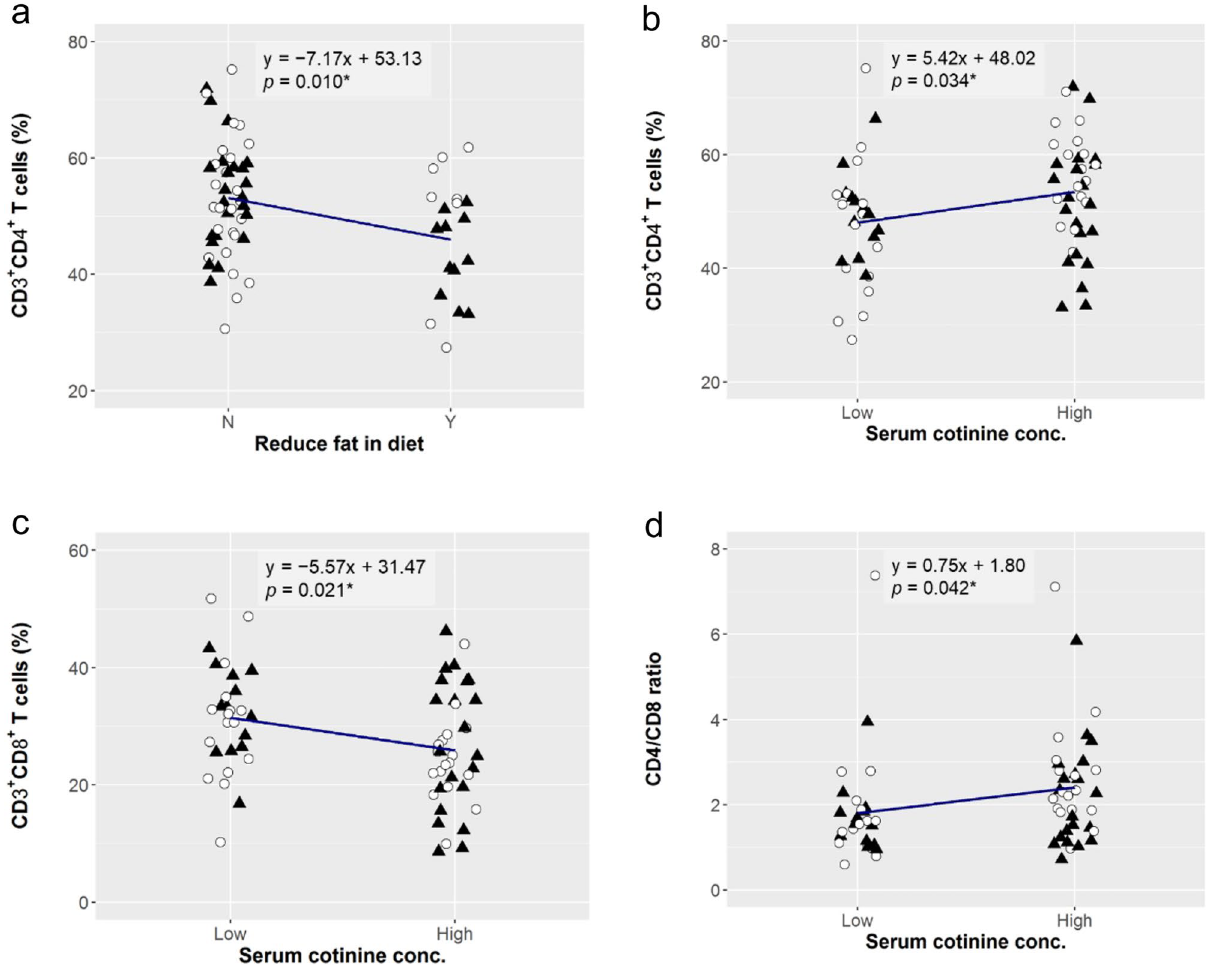
Figure 4. Effect of dietary fat intake and serum cotinine on CD4 + and CD8 + T cells. Linear regression analysis to evaluate the effect of reduce dietary fat intake on CD4 T cells ( a ), serum cotinine levels on CD4 + T cells ( b ), CD8 + T cells ( c ), and the ratio of CD4/CD8 T cells ( d ) in the PBMCs. The linear regression curve was plotted for the data of 67 subjects (33 females: open circle, 34 males: closed triangle), and its equation and p -value (* p < 0.050) for the effect size of the explanatory valuable are